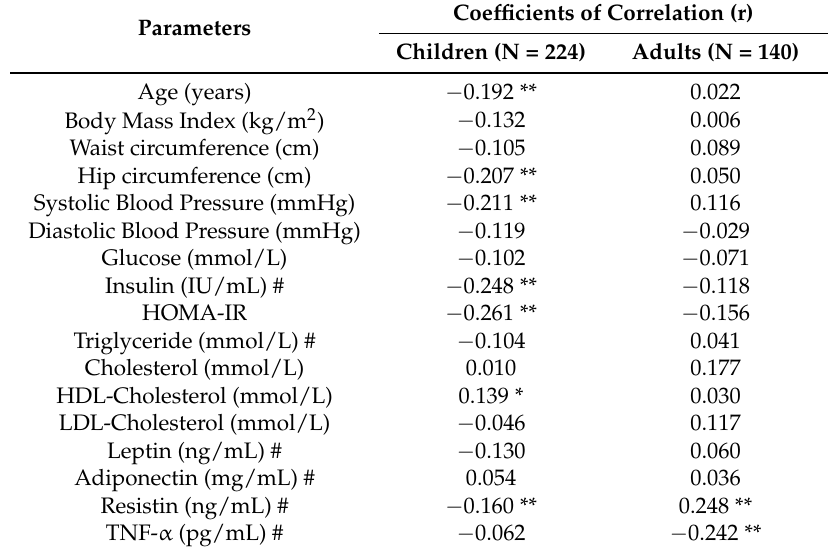
Table 2. Associations between vitamin B12 and clinical, glycemic, lipid and metabolic profiles.